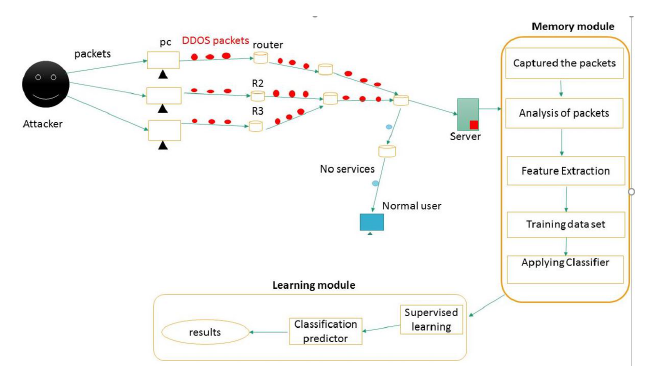
Figure 4. Proposed